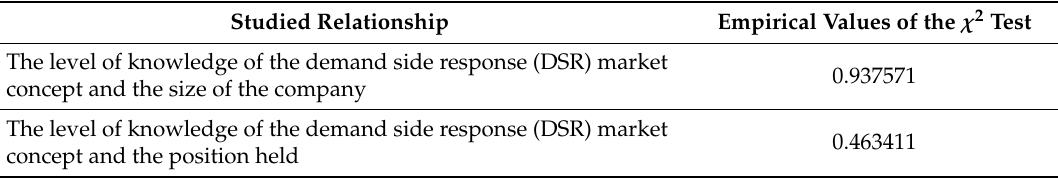
Table 4. Empirical values of the χ 2 test for the studied relationships (the level of knowledge of the